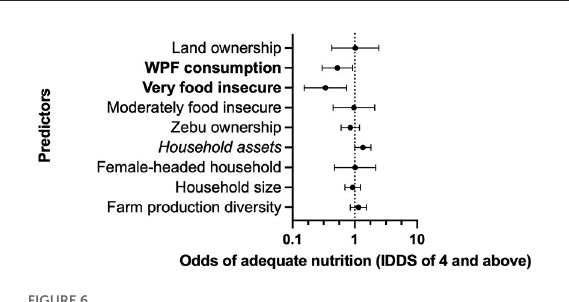
FIGURE6 Standardized effects of predictor variables on adequate nutrition based on individual dietary diversity scores (IDDS) of four and above. Points represent the odds ratio estimates with upper and lower 95% confidence intervals. Bolded predictors indicate significance at the p < 0.05 level. Italicized predictors indicate significance at the p < 0.10 level. The value of 1 on the x-axis (dashed line) is equivalent to no effect. Results based on a multilevel random effects model of data from 302 respondents.